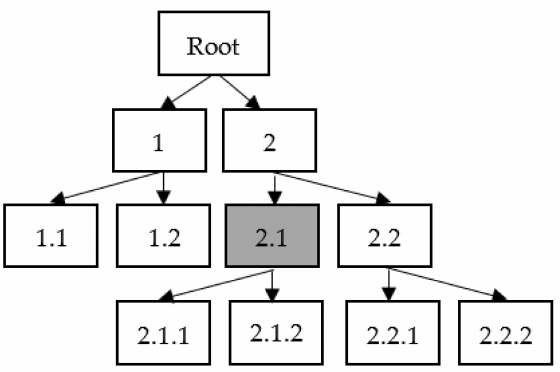
Figure 2. Hierarchical classification using Local Classification on the Parent Node (LCPN).